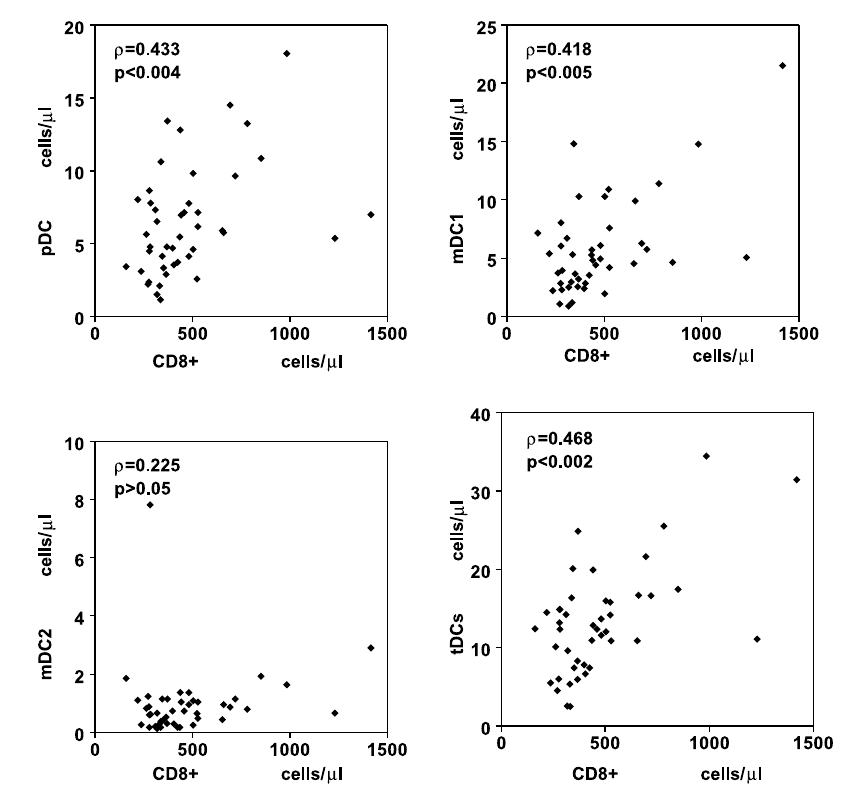
FIG. 3. Correlations between the number of T CD8 (cid:2) cells and total dendritic cells (tDC) and their pDC and myeloid (mDC1 and mDC2) subpopulations in the peripheral blood of SLE patients.